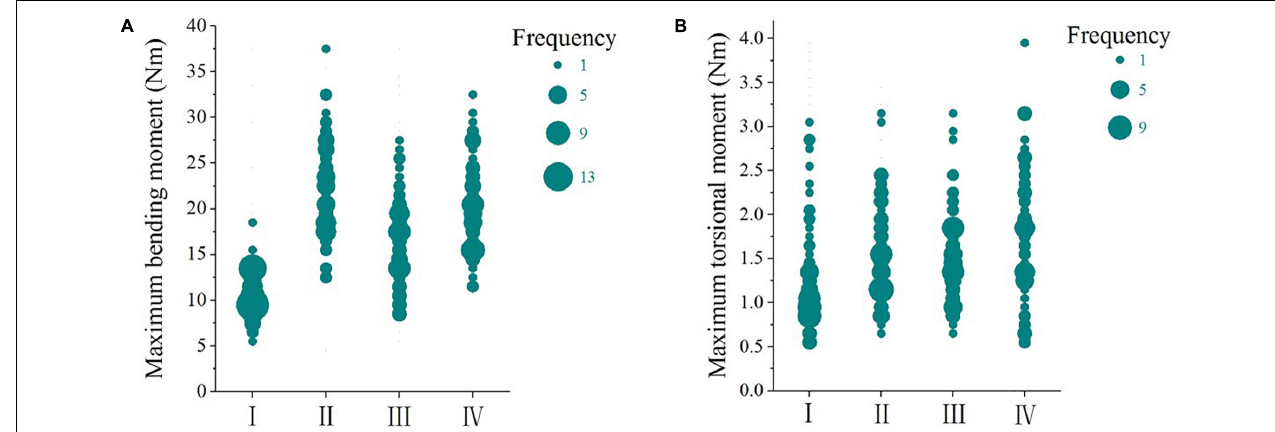
FIGURE 10 | Typical stalk bending moment curves under tested harvesting conditions. (A) Upright stalks; (B) forward lodged stalks; (C) reverse lodged stalks; (D) lateral lodged stalks.